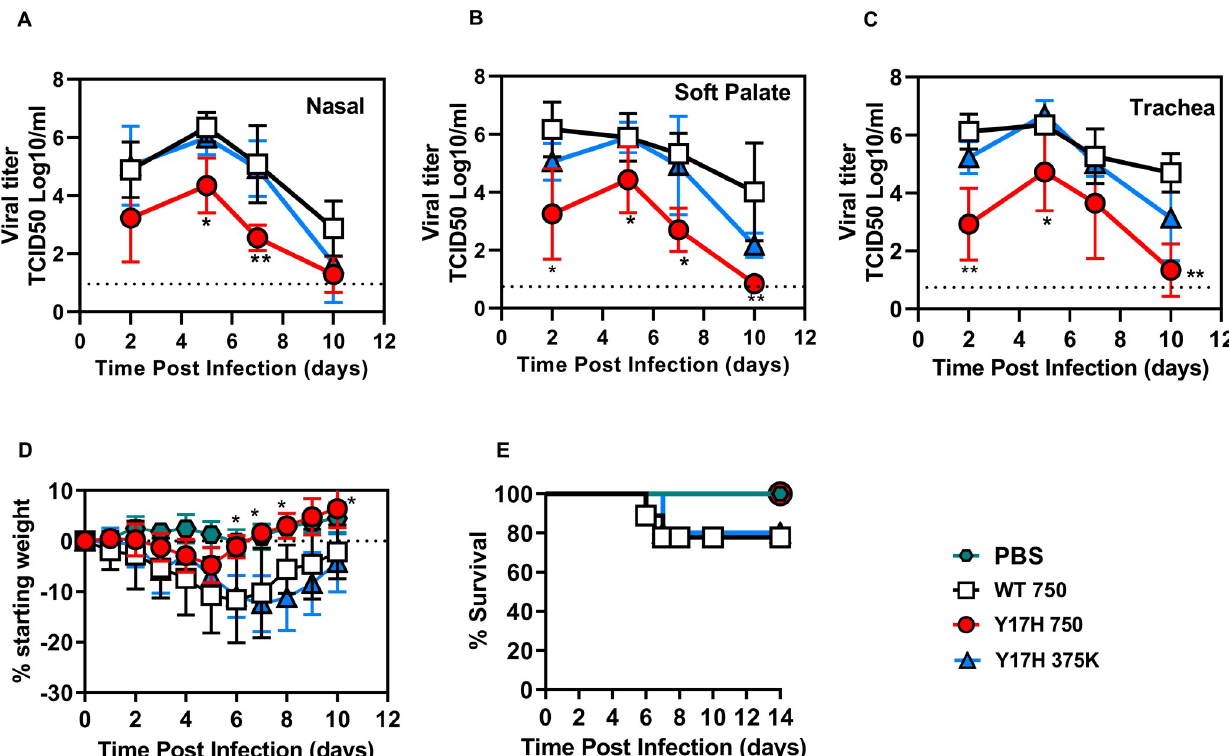
Fig 2. Tissue viral titers and body weight loss in DBA/2 mice infected with A/TN/09 variants. (A-C) Nasal, soft palate, and tracheal tissue titers at 2, 5, 7- and 10-days post infection (DPI). The inoculated doses were 750 PFU for WT and 750 or 375,000 PFU for Y17H. Values are the mean ( ± SD) for three mice, with a total of 12 mice at each time point. (D-E) Changes from starting body weight and percent survival of DBA/2 mice after inoculation with 750 PFU of WT and 750 or 375000 PFU of Y17H. Symbols used in all panels as follows: PBS (green hexagon), WT 750 (black squares), Y17H 750 (red circles), and Y17H 375 (blue triangles). Statistical significance was determined by two-way ANOVA and Tukey posthoc analysis, comparing each set of results to those for WT virus. Significant statistical differences are indicated as follows: � , P < 0.05; �� , P < 0.01; ��� , P < 0.001; ���� , P < 0.0001.